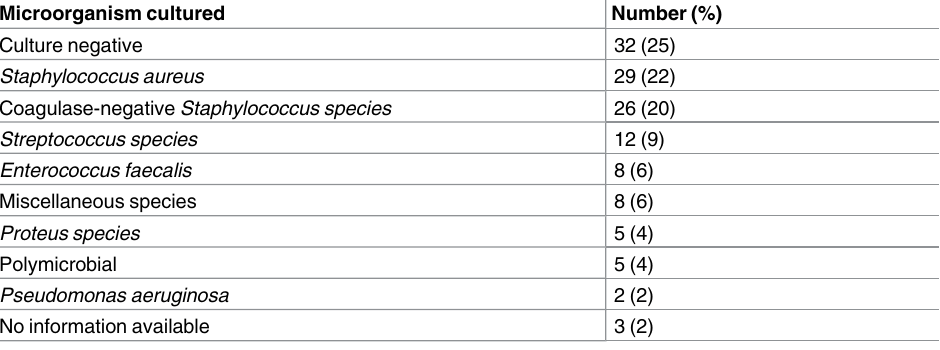
Table 2. Microorganism cultured in 130 patients treated for chronic hip PJI between 2003 and 2008. Microorganism